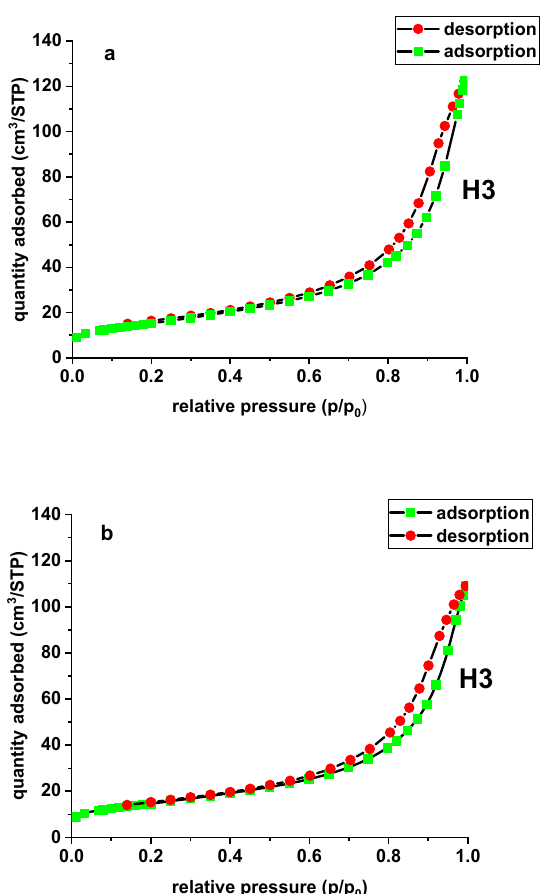
Figure 3. N 2 adsorption/desorption isotherms of X np ( a ) and X np -La(III) ( b ). FTIR spectra of X np and X np -La(III) were collected before and after sorption of As(V) ions ( Figures 4 and 5). The bands at 3600-3200 cm − 1 indicate an O-H stretching group on the surface of iron oxide.